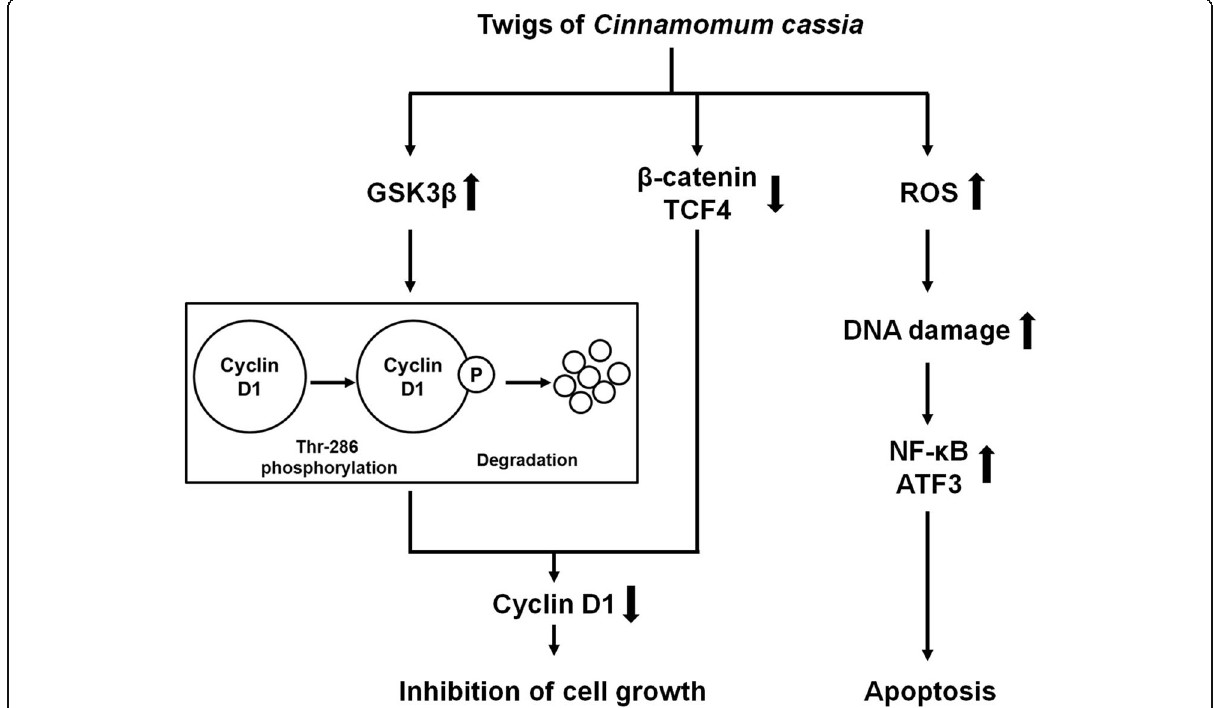
Fig. 8 The potential mechanism of TC-HW for anticancer